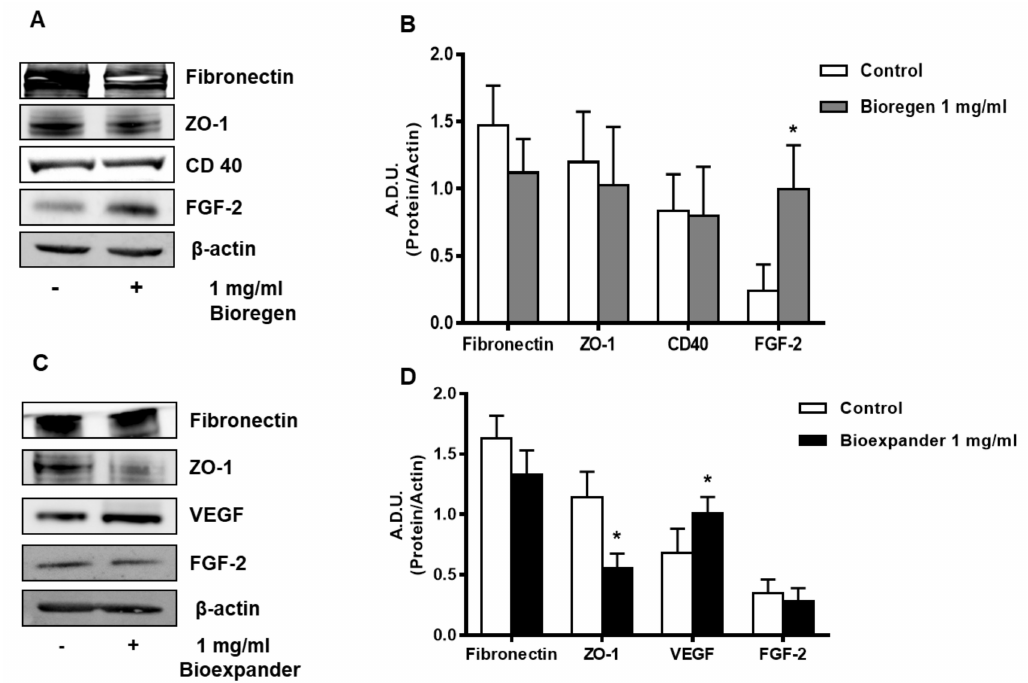
Figure 3. Analysis of the angiogenesis and inflammatory markers following HA exposure of skin fibroblasts. NHDFs were treated for 18 h with 1 mg / mL Bioregen ® (grey columns) ( A , B ) and Bioexpander ® (black columns) ( C , D ). In panels ( A , C ), a representative blot out of 3 is shown, while panels ( B , D ) report protein quantification. Data are reported as A.D.U. of the protein of interest with respect to beta-actin. * p < 0.05 vs. basal control